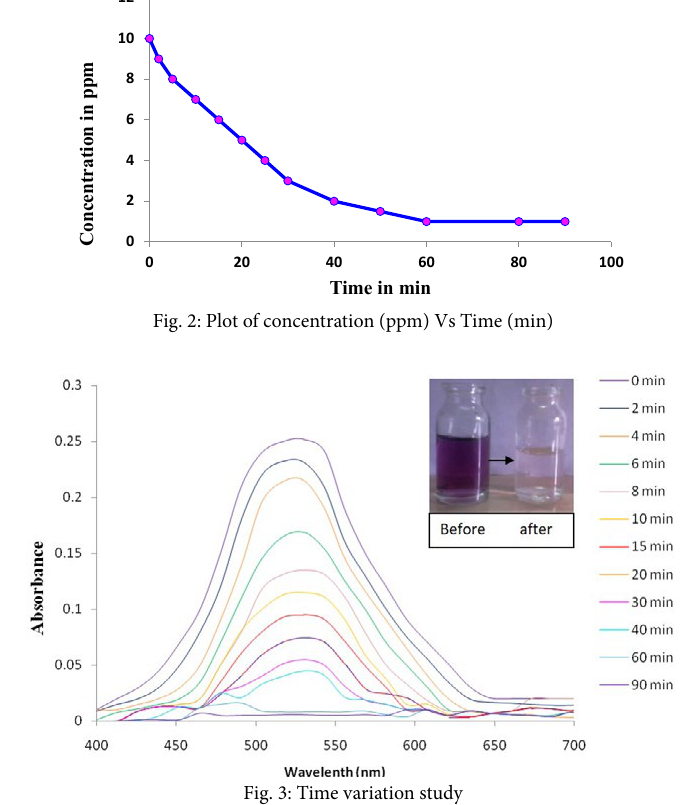
Fig. 3: Time variation study